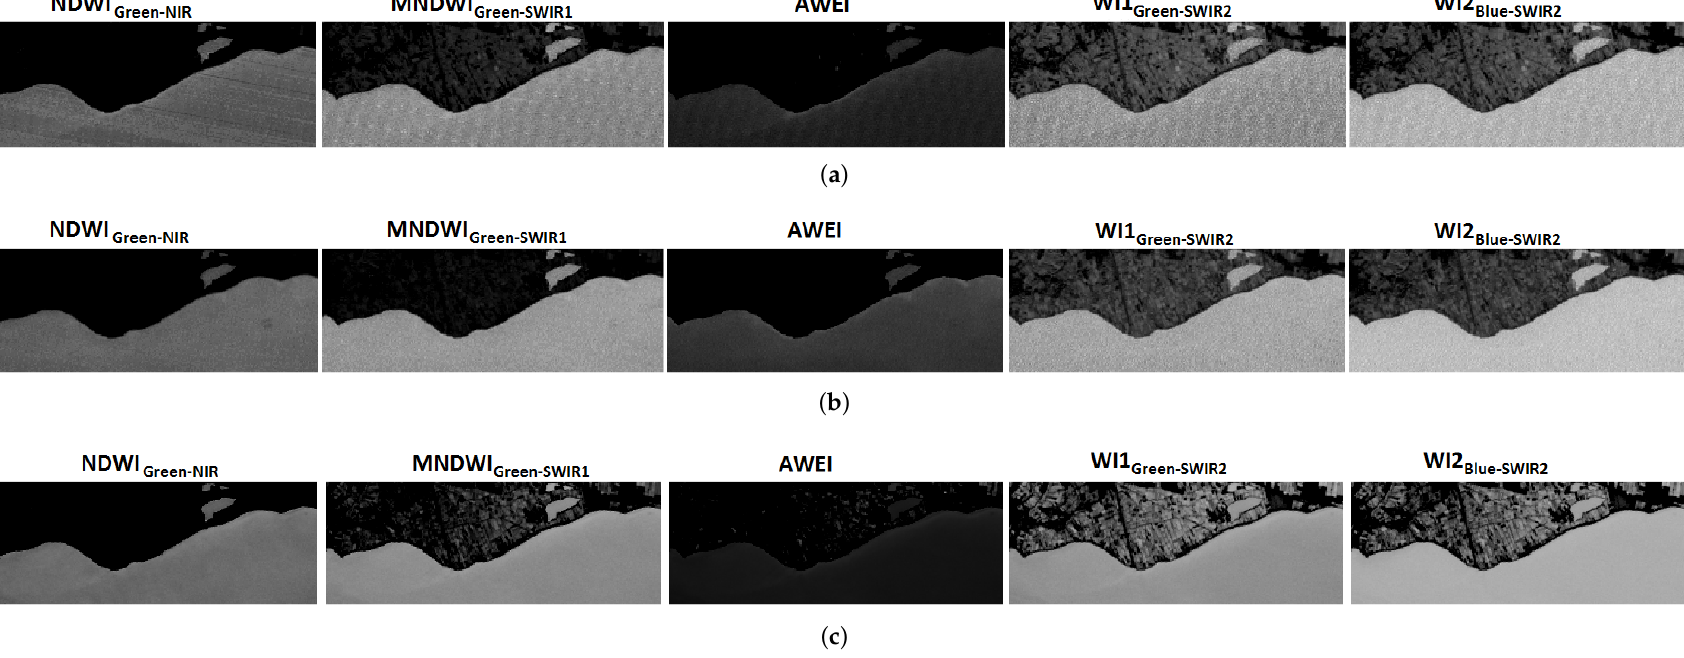
Figure 8. Water Indexes calculated for comparison in each of the sensors selected: TM, ETM+, and OLI in the Adra River Delta. ( a ) The water indexes calculated on a TM image recorded on 9 October 2011. ( b ) The water indexes calculated on an ETM+ image recorded on 6 September 2002. ( c ) The water indexes calculated on an OLI image recorded on 20 December